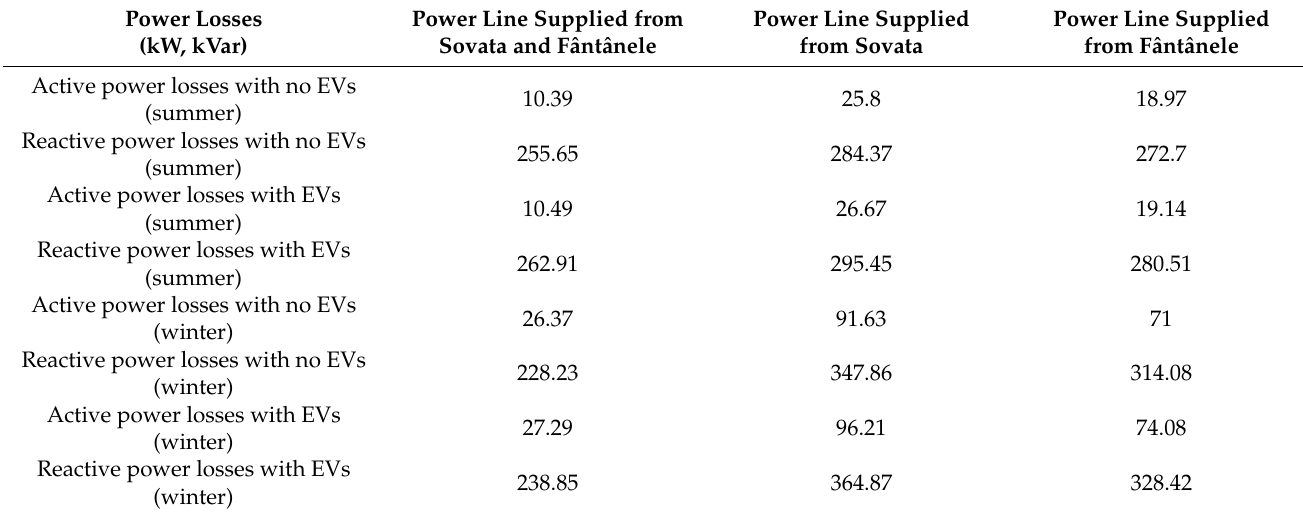
Table 17. Power losses at 10:00 (scenario